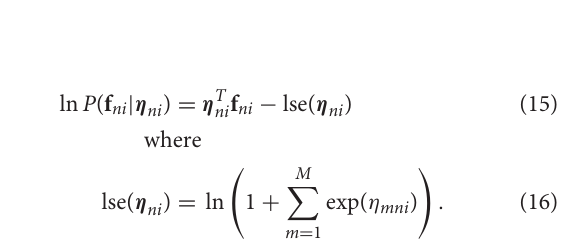
FIGURE 1 | Generative model for a single patch. Data from N subjects are assumed to be patches containing categorical data. Image voxels are denoted by f (1) ni (where n ∈ [1.. N ] and i ∈ [1.. I (1) ]) and label voxels by f (2) ni ( i ∈ [1.. I (2) ]). These are encoded by their means ( µ (1) i and µ (2) i , respectively) and a linear combination of basis functions ( W (1) i and W (2) i , respectively). For each subject, the contributions of the two sets of basis functions are jointly controlled by latent variables z n , which are assumed to be drawn from a normal distribution of mean z 0 and precision P 0